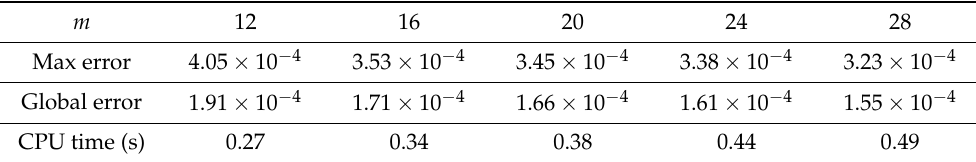
Table 3. Max and global errors of hydraulic head H and CPU time with different supporting node numbers.